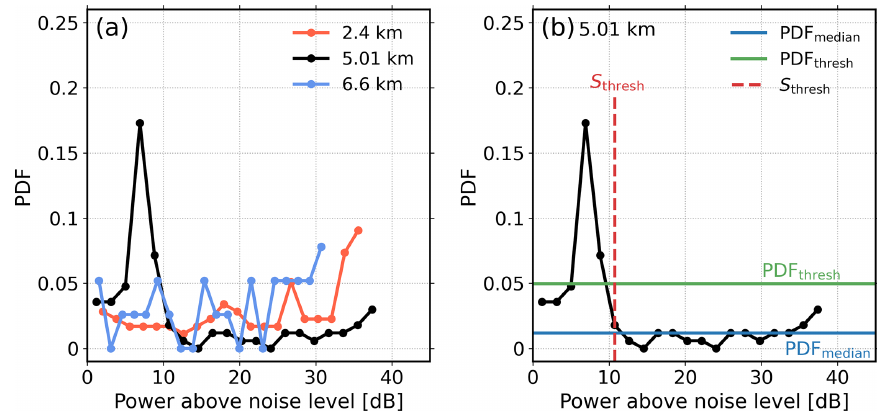
Figure 5. (a) PDFs of Doppler spectra from 2 to 7km at mode 2; (b) PDF of Doppler spectrum recorded at 5.01km.